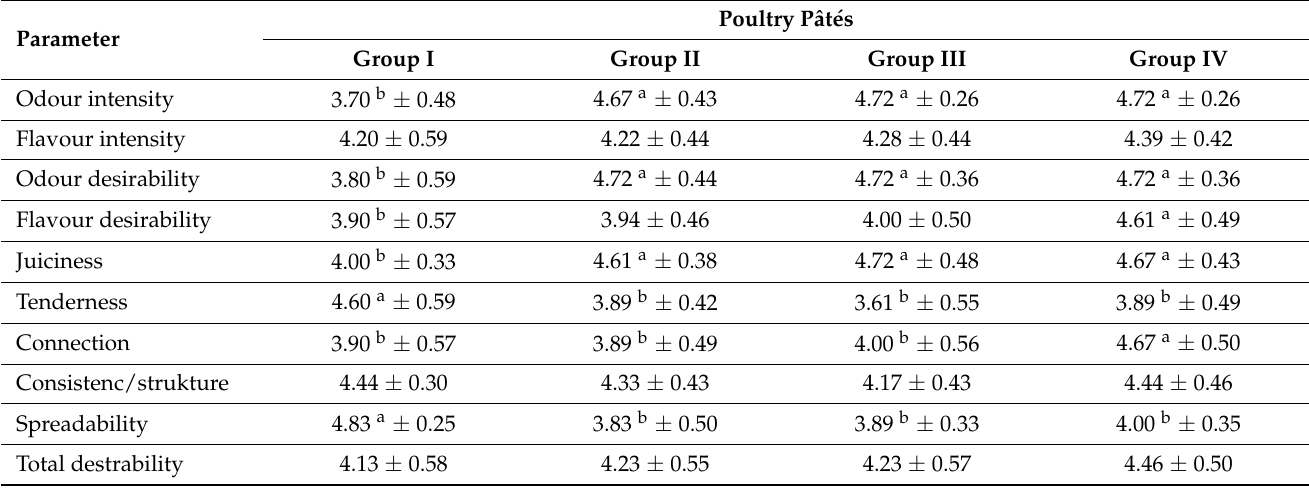
Table 6. Effect of the addition of hemp seeds, amaranth and golden flaxseed on the sensory traits of poultry p â t é s